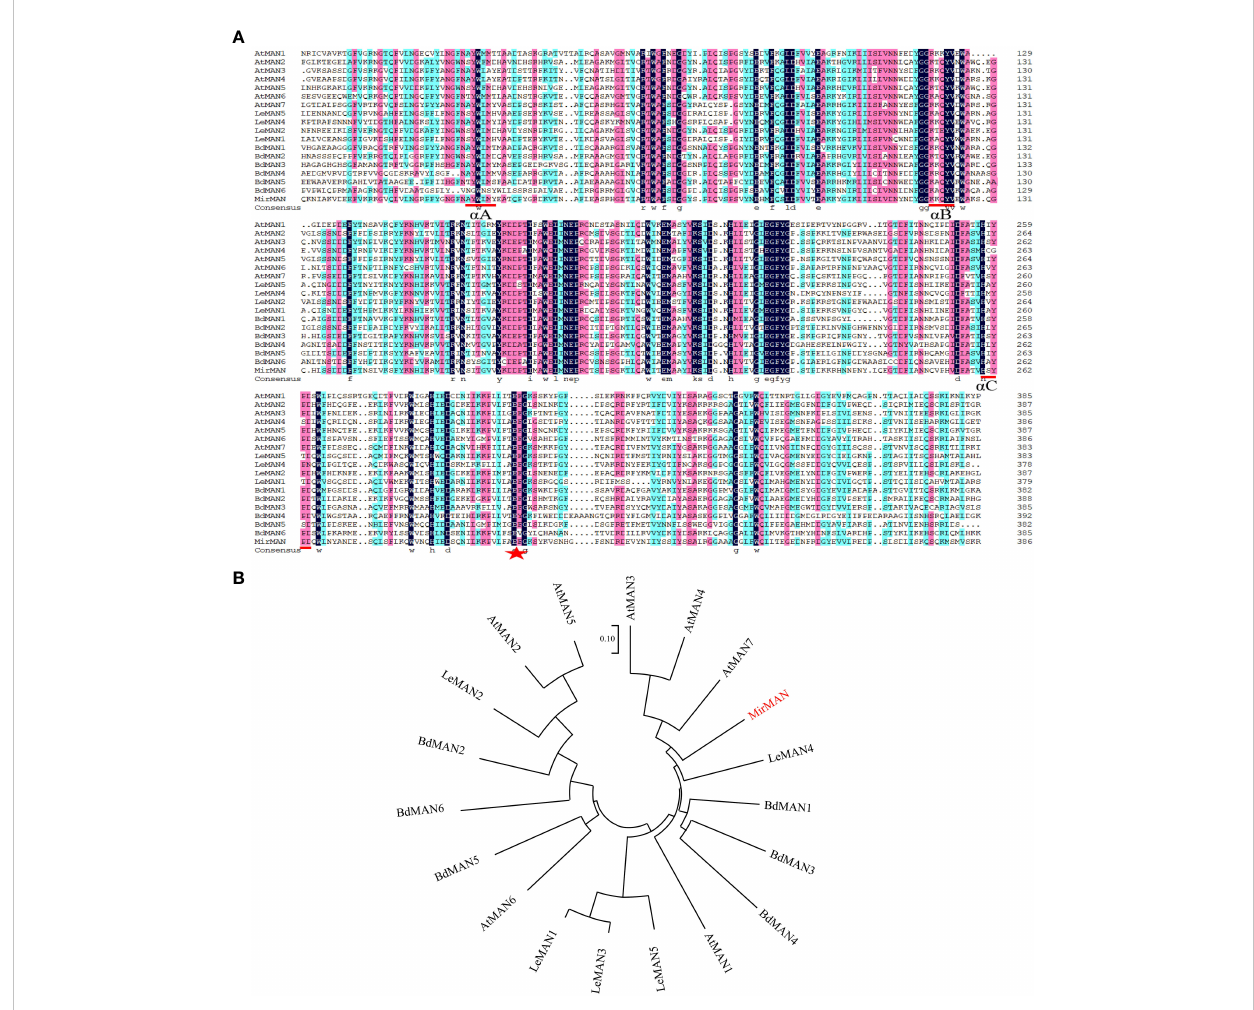
FIGURE 1 Alignment of sequences and phylogenetic tree of MirMAN proteins. (A) Alignment of sequences of MirMAN proteins and homologs from others species. Blue inverted triangles indicate signal peptide sites, red lines indicate the MAN conserved sequence, and red star indicates the catalytic glutamate residue structural motif. Multiple sequence comparisons showed that MirMAN was 46.96%, 45.85%, 43.99%, 42.65%, 42.31%, 41.79%, 39.72%, 39.15%, 39.08%, 35.71%, 35.03%, 34.98%, 34.57%, 34.41%, 33.64%, 31.98%, 31.57%, and 29.13%, consistent with LeMAN1, AtMAN7, LeMAN4, AtMAN3, AtMAN1, AtMAN4, LeMAN5, BdMAN1, LeMAN3, AtMAN6, BdMAN5, BdMAN2, AtMAN5, AtMAN2, BdMAN3, LeMAN2, BdMAN4 and AtMAN6, respectively. (B) Phylogenetic tree of MirMAN proteins from Mirabilis jalapa and other species. At, Arabidopsis thaliana ; Bd, Brachypodium distachyon ; Le, Lycopersicon esculentum